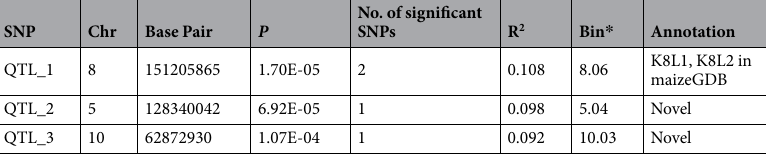
Table 3. Candidate positions related with genome size. * Bin: chromosomal